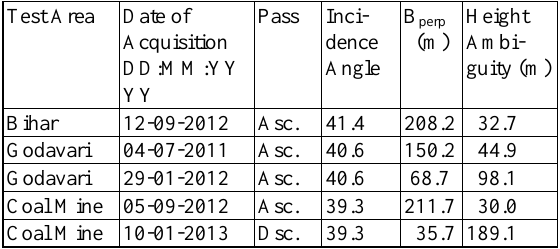
Table 1. TanDEM-X datasets used for DEM generation.